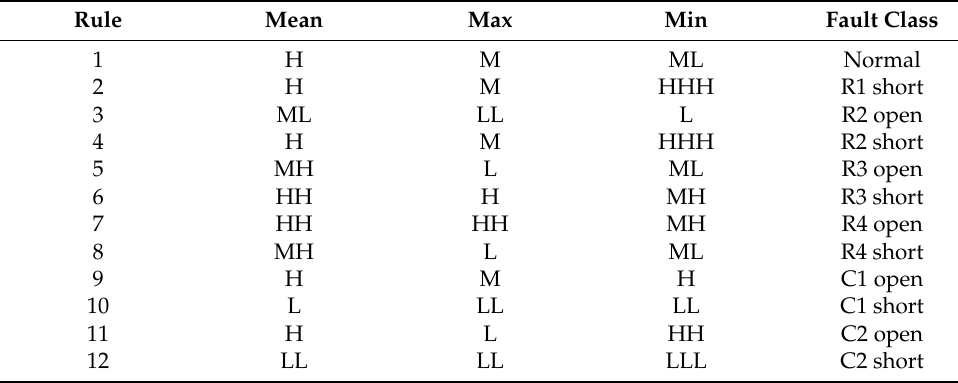
Table 2. The fuzzy logic classifier rules.